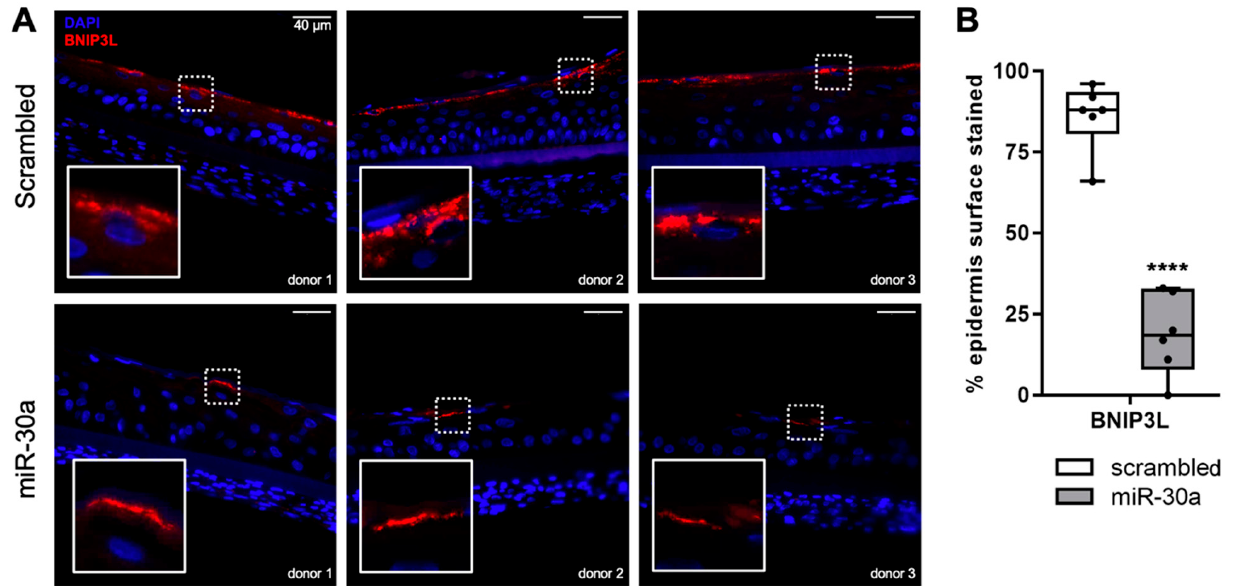
Figure 2. Effect of miR-30a on BNIP3L expression in the granular layer of reconstructed epidermis. ( A ) Immunofluorescent staining of BNIP3L in reconstructed human epidermis overexpressing miR-30a or a scrambled sequence by stable lentiviral transduction. Representative photographs of 3 independent replicates are shown. ( B ) Quantification of the surface of the epidermis with a positive signal for BNIP3L in each condition (median ± SD, n = 6; **** p < 0.0001). Exact p -value was determined using the Student’s t -test.